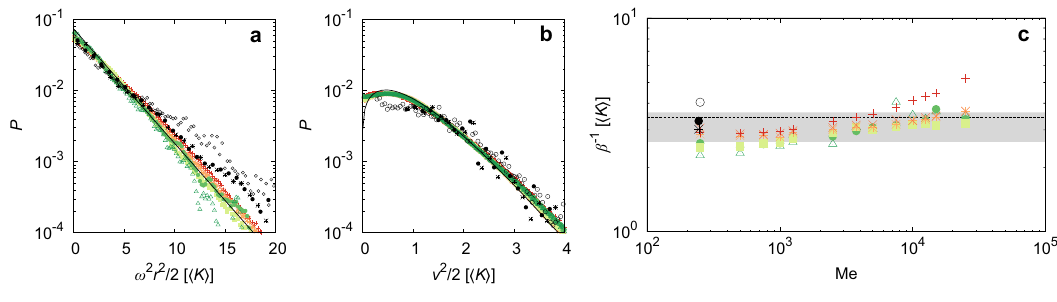
Fig. 4 Statistical description of the walker experimental and numerical dynamics. a Probability density function P of the radial position r of the walker (with respect to the center of the harmonic potential) from both simulations and experiments. The potential energy U = ω 2 r 2 /2 is measured in K units. Colored points: simulations for a memory parameter Me = 2500 and various frequencies ω /2 π = 0.25 Hz (red plus), 0.125 Hz (orange cross), 0.1 Hz (light orange star), 0.05 Hz (yellow-green square), 0.025 Hz (light-green circle), 0.01 Hz (green triangle). Black symbols: three independent experiments at different frequencies of the harmonic potential and memory ( ω /2 π (Hz),Me): (0.20,244) (black star), (0.36,250) (black open circle), (0.30,244) (black fi lled circle). Black lines: theoretical predictions. b Probability density function of the speed v of the walker from both simulations and experiments. The same color code as in ( a ) is used. c Evolution of the effective temperature per unit mass β − 1 . Color code is that of ( a and b ) but for increasing Me parameter. Dash line: value of β − 1 averaged over Me. Gray area: fl uctuations of β − 1 averaged